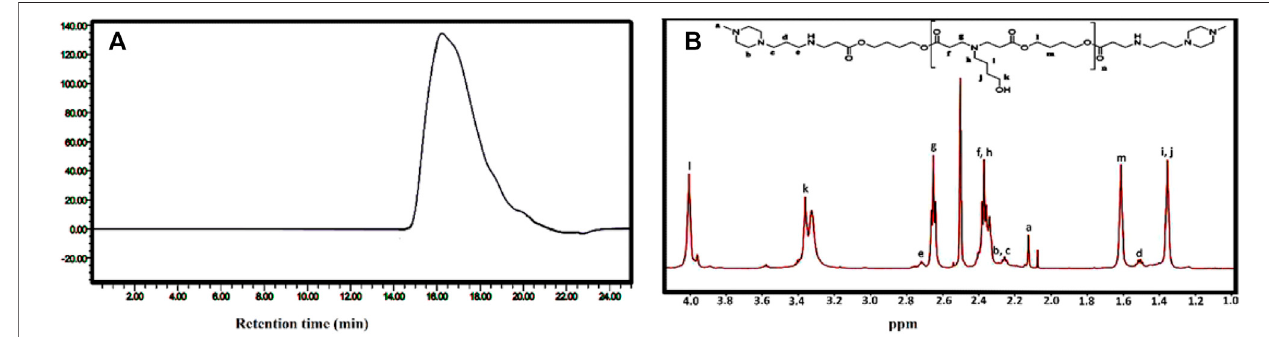
FIGURE 2 | Characterization of P β AE-447: (A) GPC chromatogram and (B) 1 H NMR spectrum in CDCl 3 .